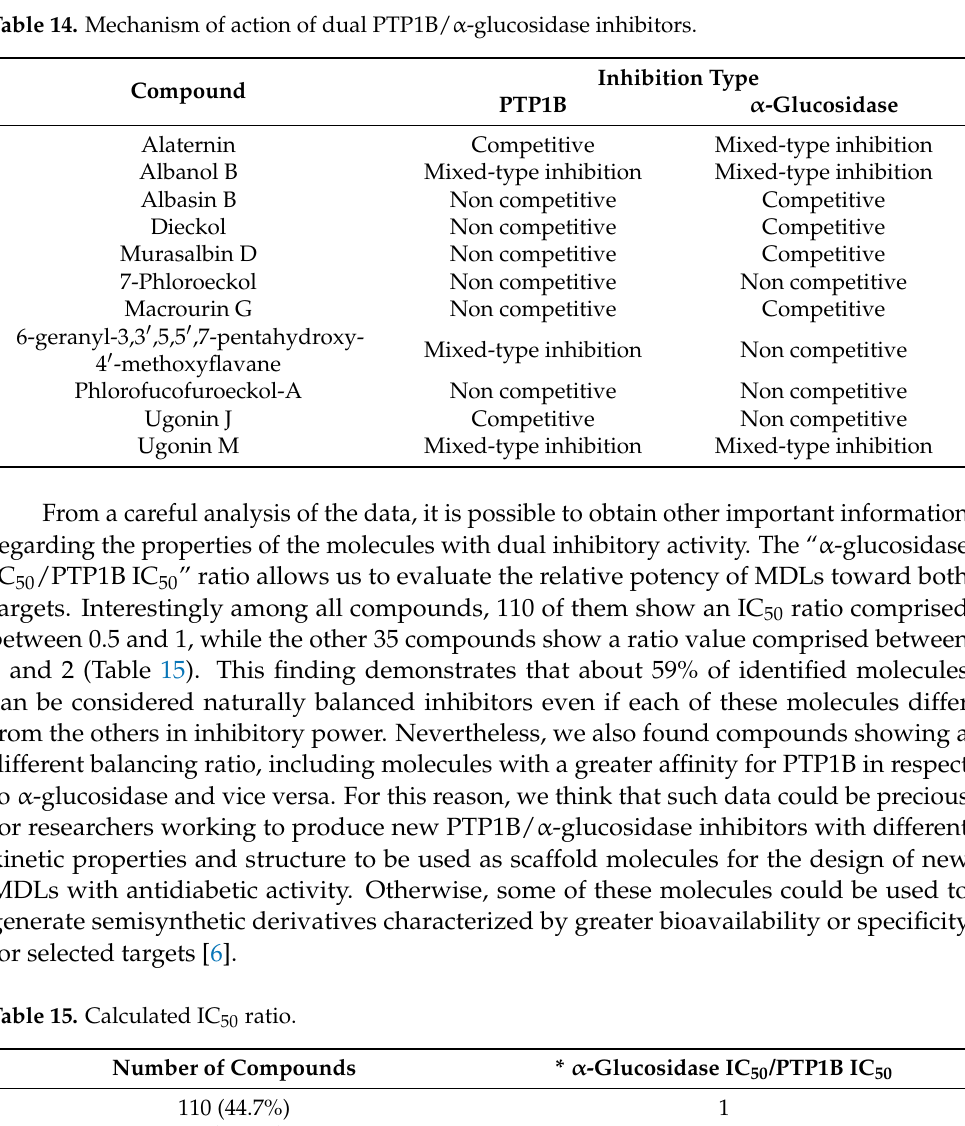
Table 14. Mechanism of action of dual PTP1B/ α -glucosidase inhibitors. Compound Alaternin